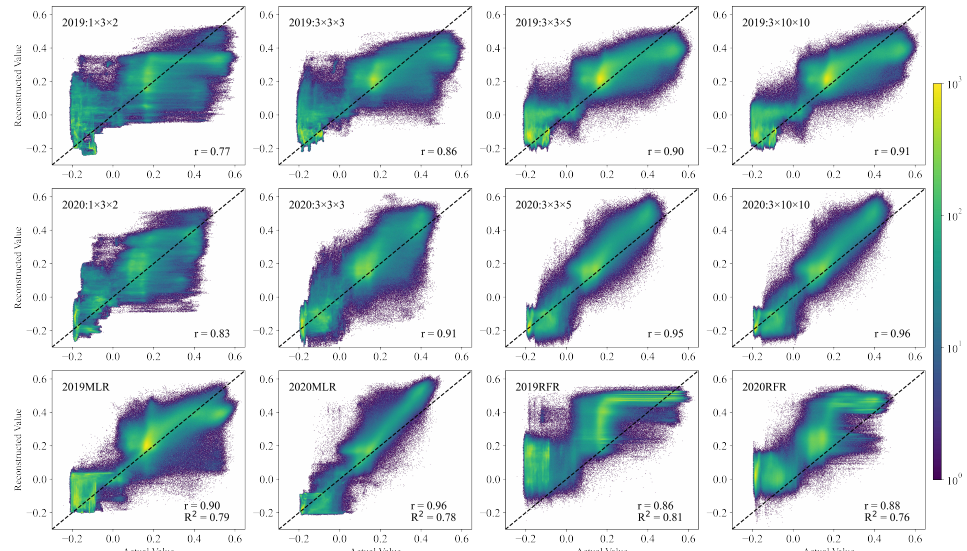
Figure 5. Scatter plots between actual and reconstructed values for different rank sizes (r: Pearson correlation coefficient, R 2 : coefficient of determination). Table 3. Statistical characteristics of actual and reconstructed values.